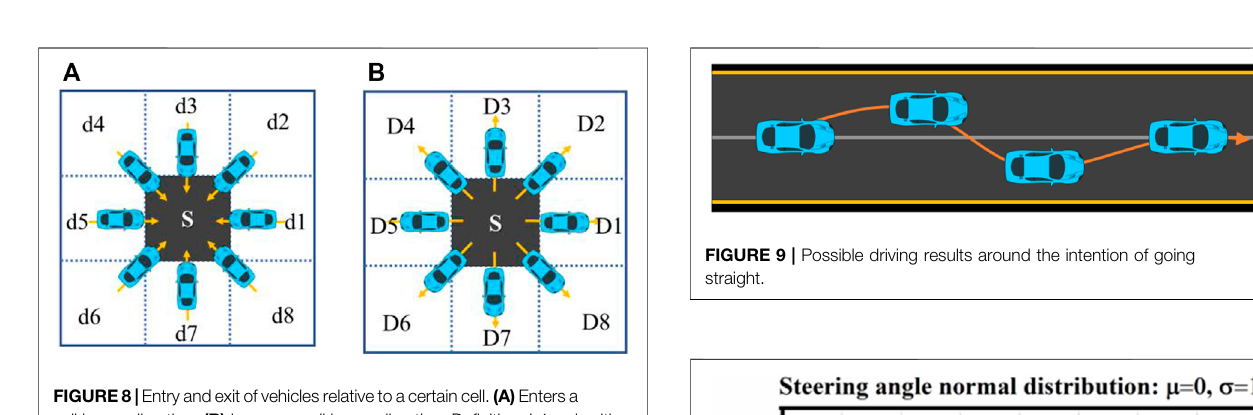
FIGURE 7 | Add and delete expected paths. (A) Vehicle initial position. (B) Replanning path with change of head direction.